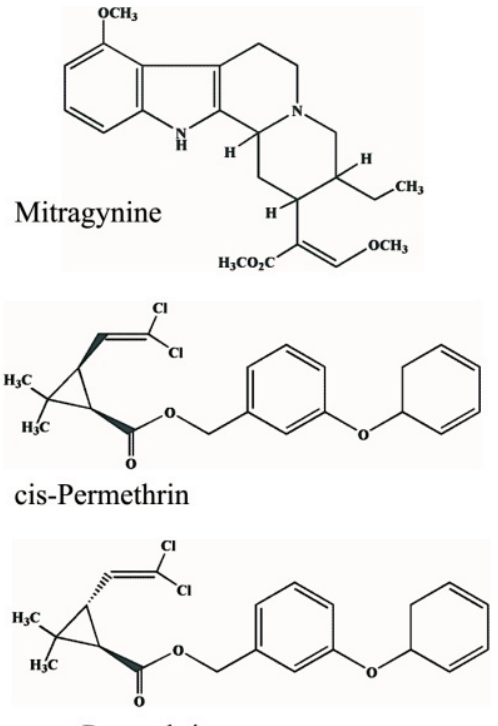
Figure 1. Chemical structures of mitragynine and permethrin ( cis - and trans